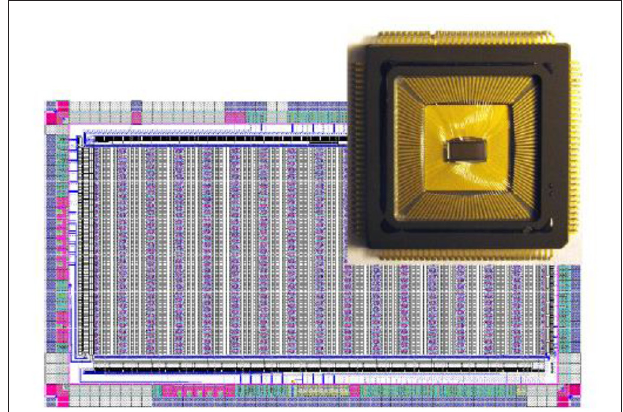
FIGURE 18 | 2DIFWTA chip layout and photograph. The 2DIFWTA chip was implemented using a standard 0.35- µ m four-metal CMOS technology and covers an area of about 15 mm 2 .